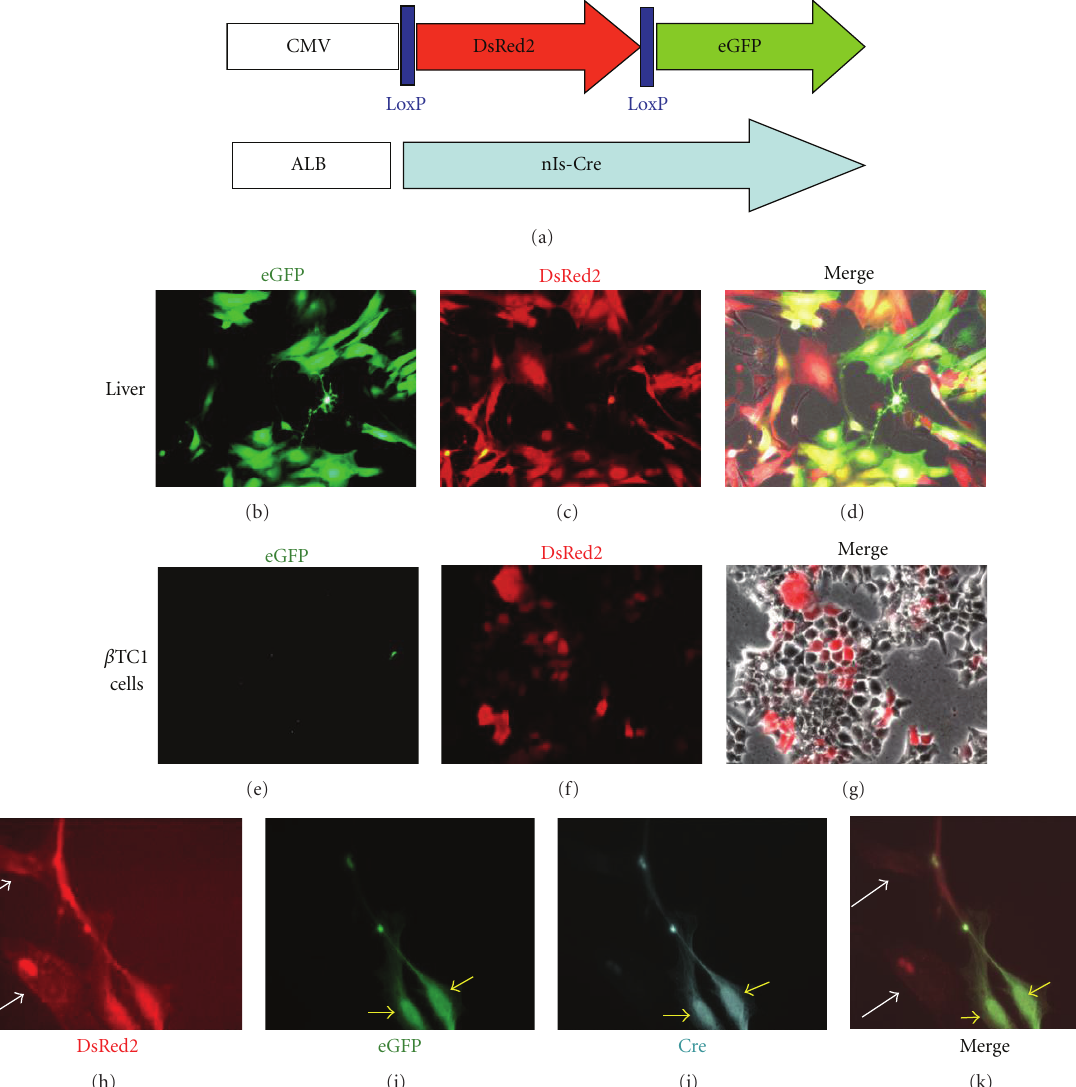
Figure 3: Irreversible labeling for albumin expression using the dual lentivirus system (lineage tracing). (a) Schematic presentation of the lentivirus vectors. (b–d) Adult human liver cells or (e–g) β -TC1 cells were infected with the reporter virus in combination with ALB-Cre virus. Liver cells were imaged 10 days after infection for DsRed2 (red) or eGFP (green) autofluorescence (original magnification × 10). (h–k) Immunostaining of adult human cells infected with both viruses for Cre (blue, (j)), eGFP (green, (i)), and DsRed2 (red, (h)). (k) Merged image of all stainings. White arrows indicate DsRed2-positive cells. Yellow arrows indicate eGFP and Cre double positive cells. Original magnification ×